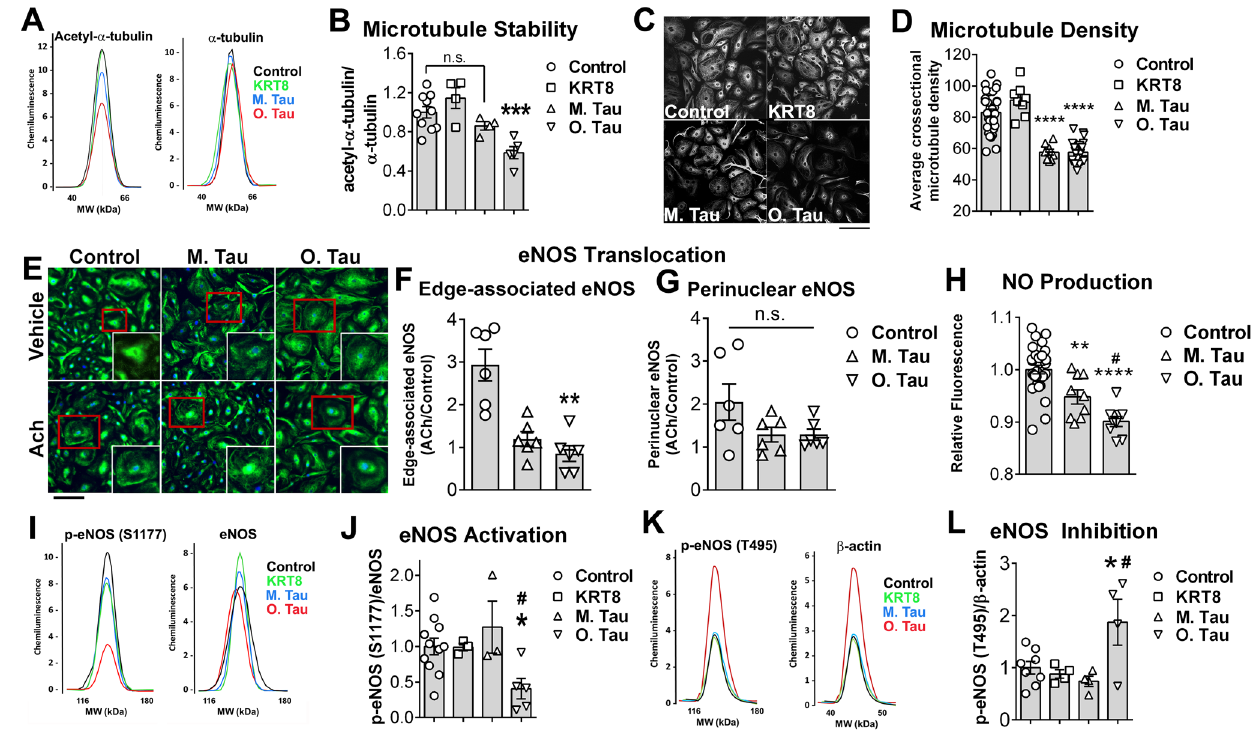
Fig. 2 | Soluble tau aggregates destabilize microtubules, reduce microtubule density, and block eNOS activation in human brain microvascular endothelial cells.A , B Solubletauaggregatesdestabilizemicrotubulesinprimaryhumanbrain microvascular endothelial cells (HBEC). A Representative electropherograms from capillaryelectrophoresisimmunoassaysofacetyl- α -tubulinand α -tubulininlysates of cells treated with recombinant human cytokeratin-8 (KRT8), monomeric tau protein (M. Tau), soluble tau aggregates (O.Tau), or vehicle (control). B Quantitative analyses of data represented in ( A ). (F(3,19)=9.871, ANOVA, P =0.0004, O. Tau different from Control by Tukey ’ s test, *** p <0.001. Control, n =11; KRT8, n =4; M. Tau, n =4, O.Tau, n =5 biologically independent samples examinedover6independentexperiments.Dataaremeans±SEM. C , D Solubletau aggregates reduce microtubule density in HBEC. C Representative images of β - tubulin immunoreactivity in HBEC exposed to KRT8, M. Tau, O.Tau, or vehicle (control). Scale bar is 200 µ m. D Quantitative analyses of microtubule density distributions from data in C ( H =49.37, P <0.0001, Kruskal – Wallis. M. Tau and O. TaudifferentfromControlbyDunn ’ s**** P <0.0001.Control, n =31;KRT8, n =8;M.